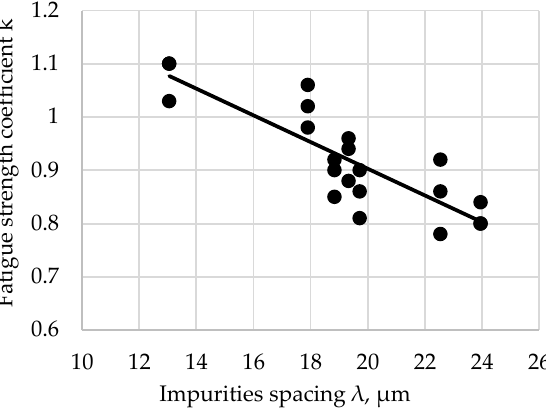
Figure 9. Fatigue strength coefficient, k , of the tested steel after hardening from 880 ◦ C and tempering for all tempering temperatures depends on impurities spacing λ . Regression equation with correlation coefficient r of the tested steel after hardening from 880 ◦ C and tempering at all tempering temperatures is presented in Equation (12).